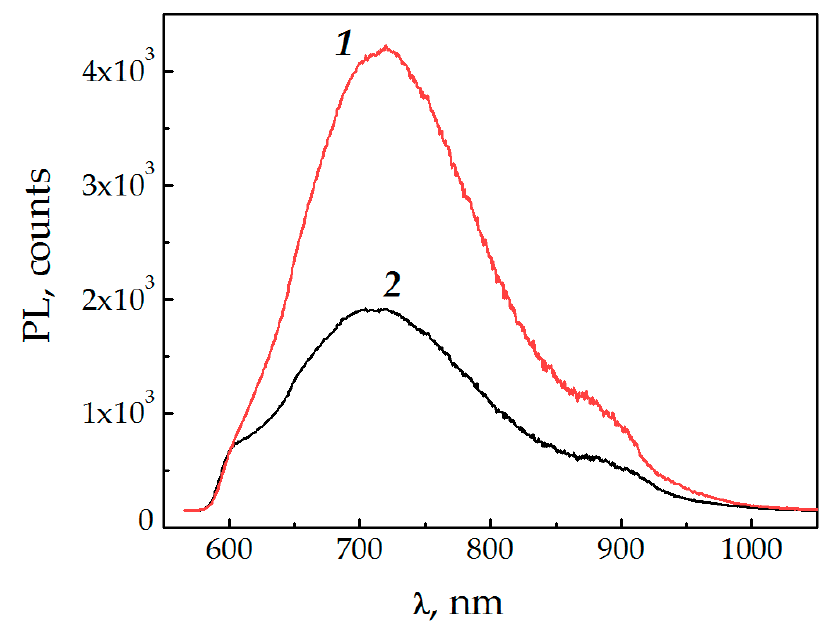
Figure 2. PL spectra of the InP/InAsP/InP-TOPO-CdSe/ZnS heterostructure at 532 nm wavelength excitation: 1 at T = 77 K; 2 at 300 K.